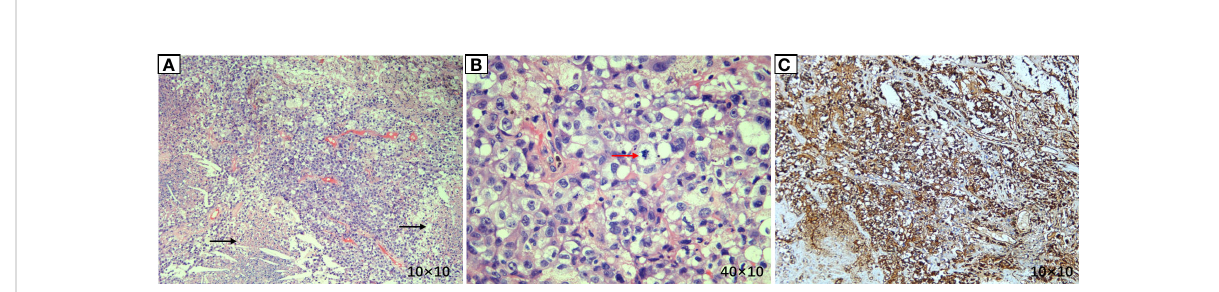
FIGURE 4 Pathological results of lung lesion biopsy. (A) (Hematoxylin and eosin (HE) × 100) Atypical tumor cells were arranged in a sheet-like manner, with vascular proliferation and necrosis. (B) (HE × 400) Atypical tumor cells showed large nuclei, hyperchromatic nuclei, prominent nucleoli, two or more nucleoli, eosinophilic or translucent cytoplasm, and pathological mitosis. (C) (IHC × 100) Vimentin was diffusely expressed, suggesting tumors derived from mesenchymal tissues.